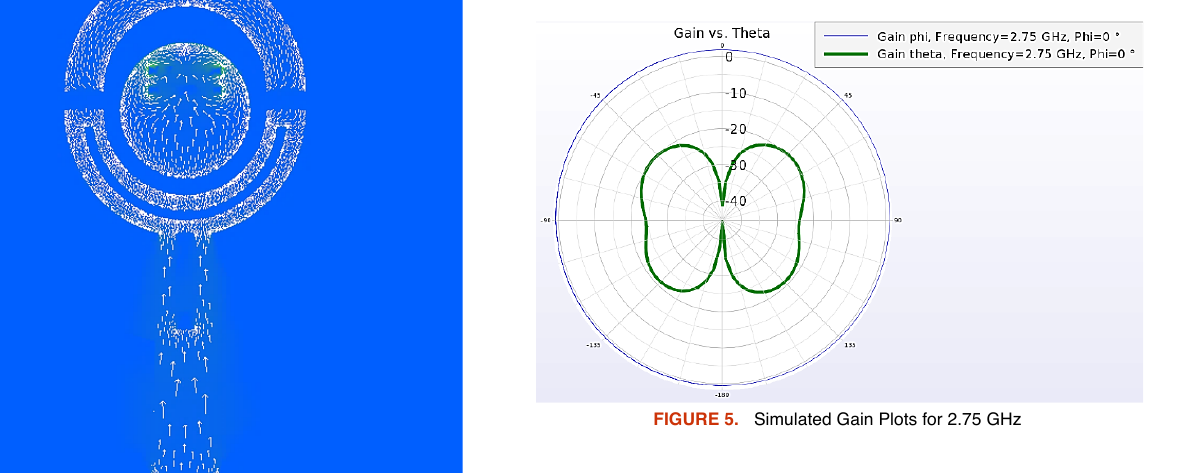
FIGURE 4. Simulated Surface Current Distributions at 3.25 GHz, (b) 3.5 GHz Another important parameter for any antenna is its radiation pattern. The individual simulated gain plots in azimuth plane (phi = 0) are obtained for the frequency points 2.75 GHz, 3.5 GHz and 3.75 GHz as shown in Fig. 5, Fig. 6 and Fig.7 respectively. From the gain plots, it is clearly visible that the antenna has nearly omni-directional radiation pattern in the entire S-Band with a gain in excess of 1.2 dB and a cross-polar suppression of -20 dB.